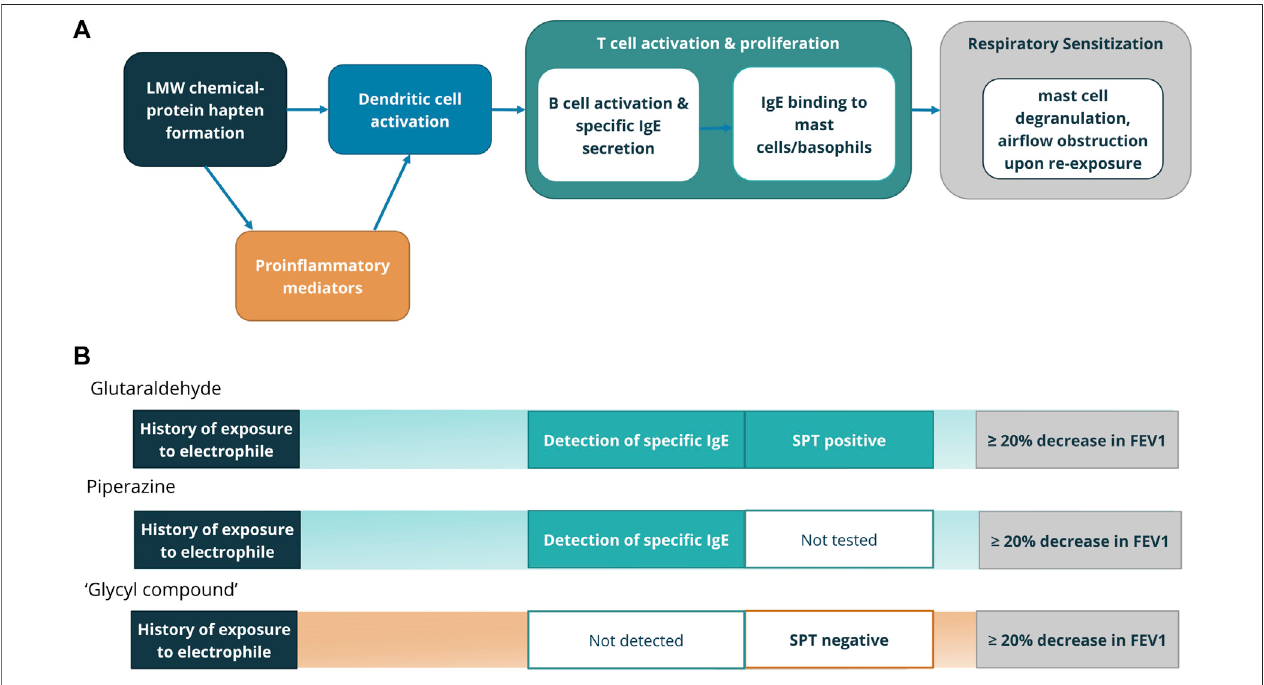
FIGURE 2| (A) Clinical diagnostic tests aligning withKey Events in the AOP for respiratory sensitization from LMW chemicals (Beckett, 2008; Sullivan et al., 2017). (B) Evidence in case reports that point to Key Events. Chemicals for which case reports included evidence of exposure, immune involvement either through direct detection of speci fi c IgE or IgG, or indirectly through a skin prick test, as well as demonstrated air fl ow obstruction were determined to be clinical respiratory sensitizers. Representative chemicals from clinical respiratory sensitizer (glutaraldehyde, piperazine) and equivocal ( ‘ glycyl compound ’ ) categories are shown with clinical evidence leading to category